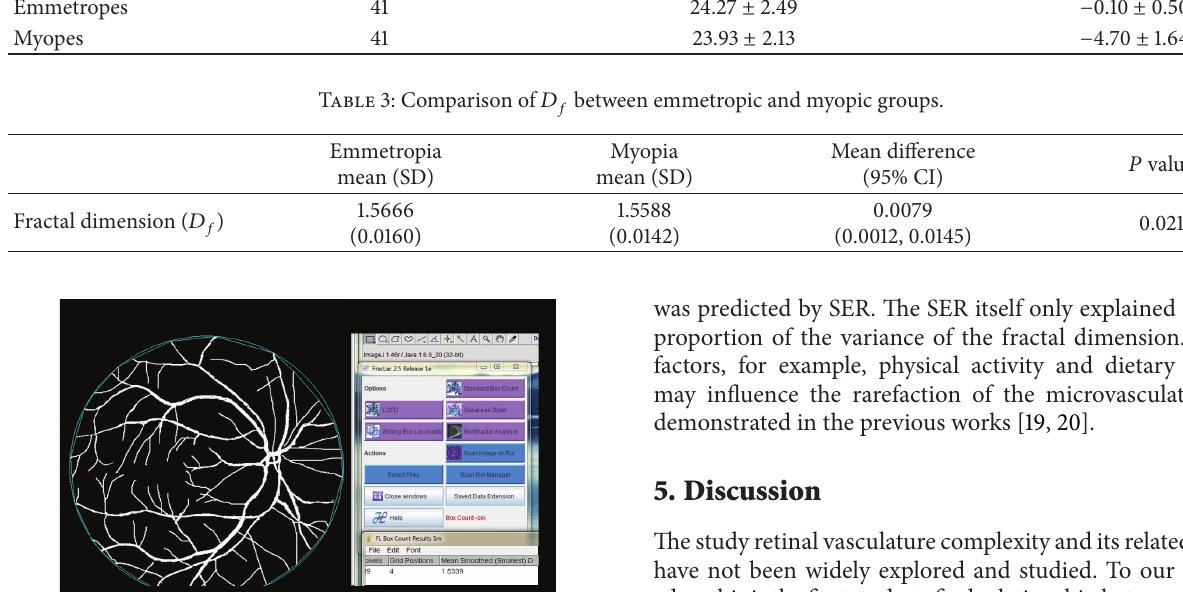
sample 𝑡 -test was used to compare the 𝐷 𝑓 between emme- tropic and myopic groups. Correlation analysis was also performed using Pearson correlation to see the trend between 𝐷 𝑓 and SER followed by simple linear regression to investigate the relationship between fractal dimension changes in response to the SER. Continuous data were used to run correlation and simple linear regression analysis. A value of 𝑃 < 0.05 was considered